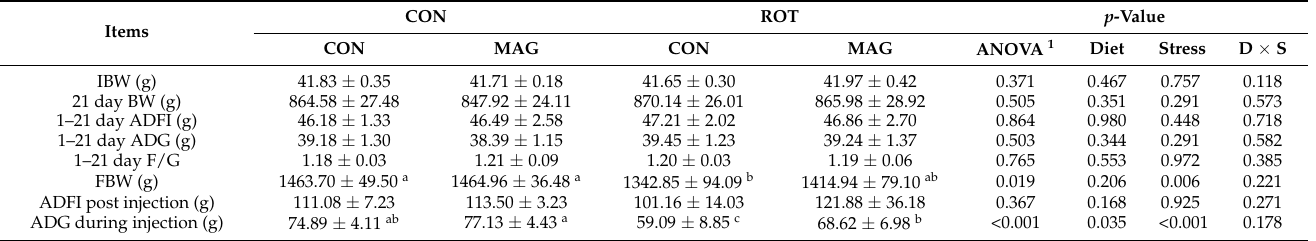
Table 3. Effect of dietary magnolol supplementation on the growth performance of broiler under rotenone